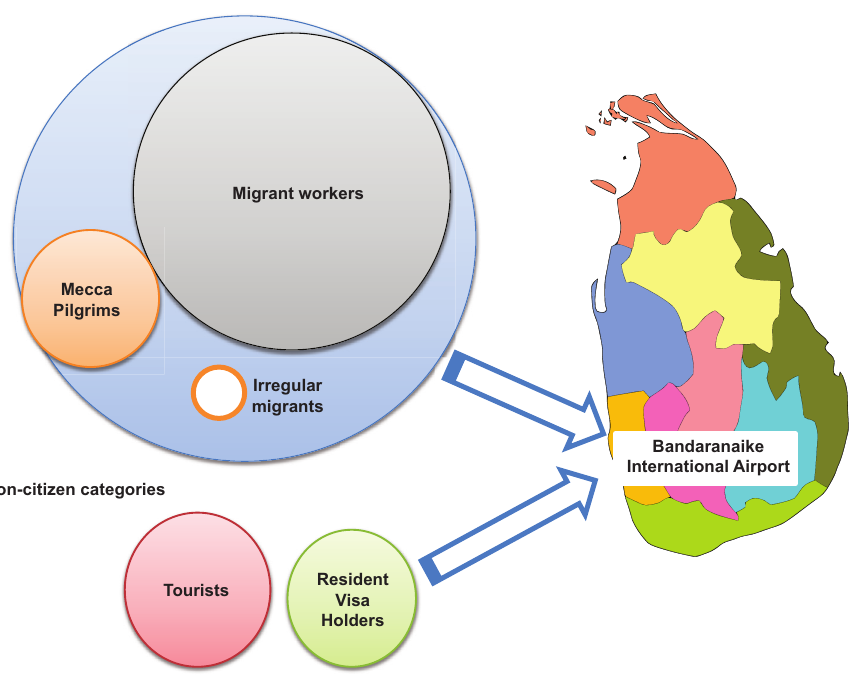
Figure 1. Categories of inbound travelers from the Middle East. This figure shows the different categories of inbound travelers arriving at the Bandaranaike International Airport, Sri Lanka.